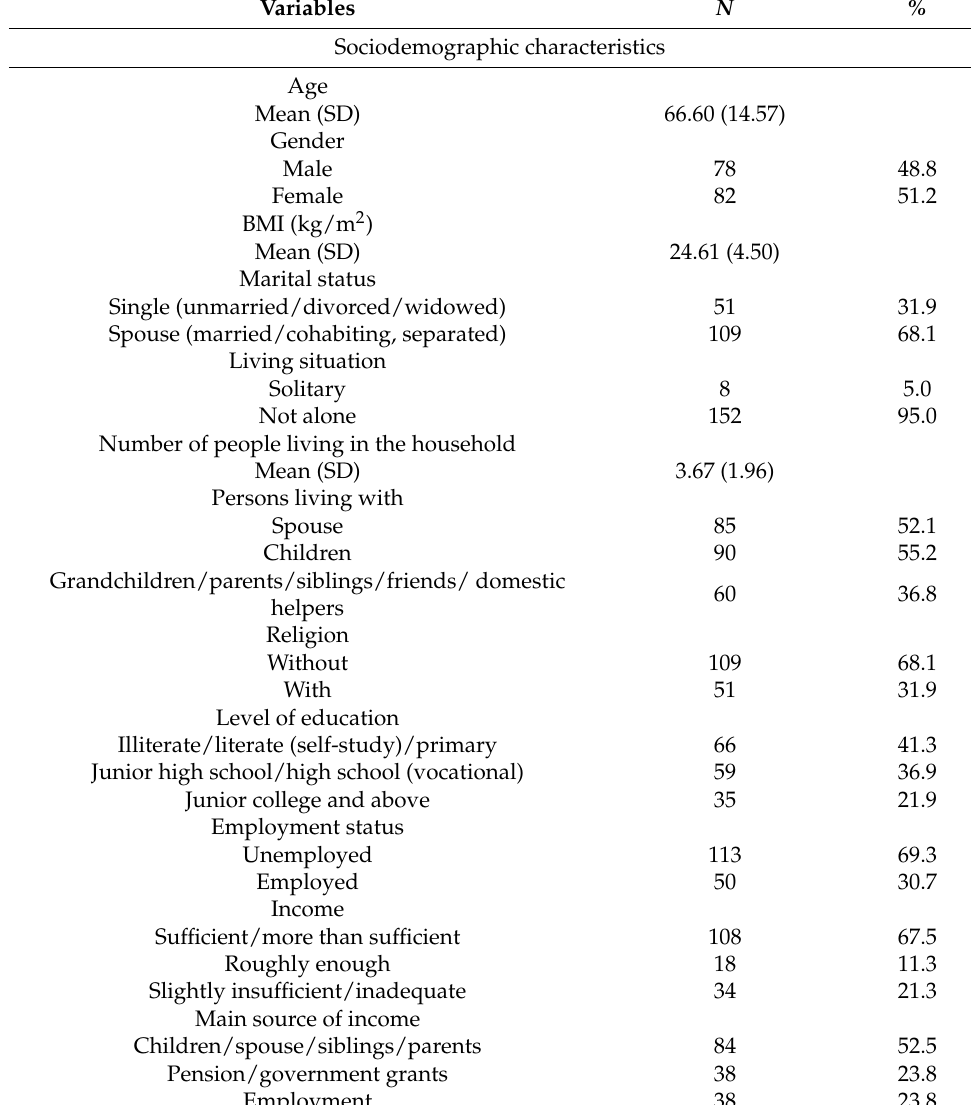
Table 1. Social characteristics and health status of patients ( N =